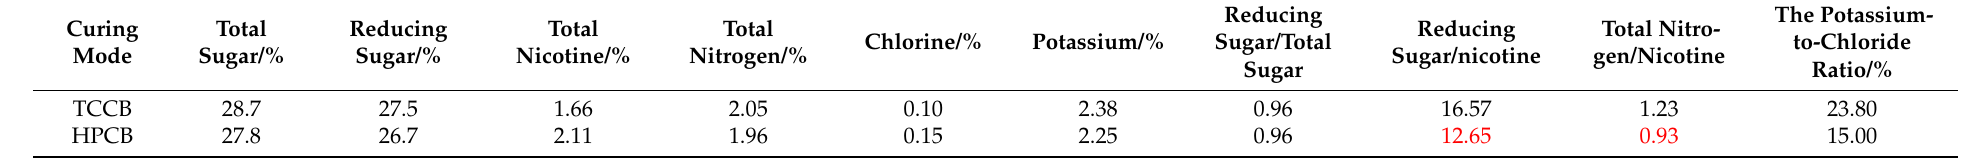
Table 8. The chemical composition of tobacco leaves after curing.